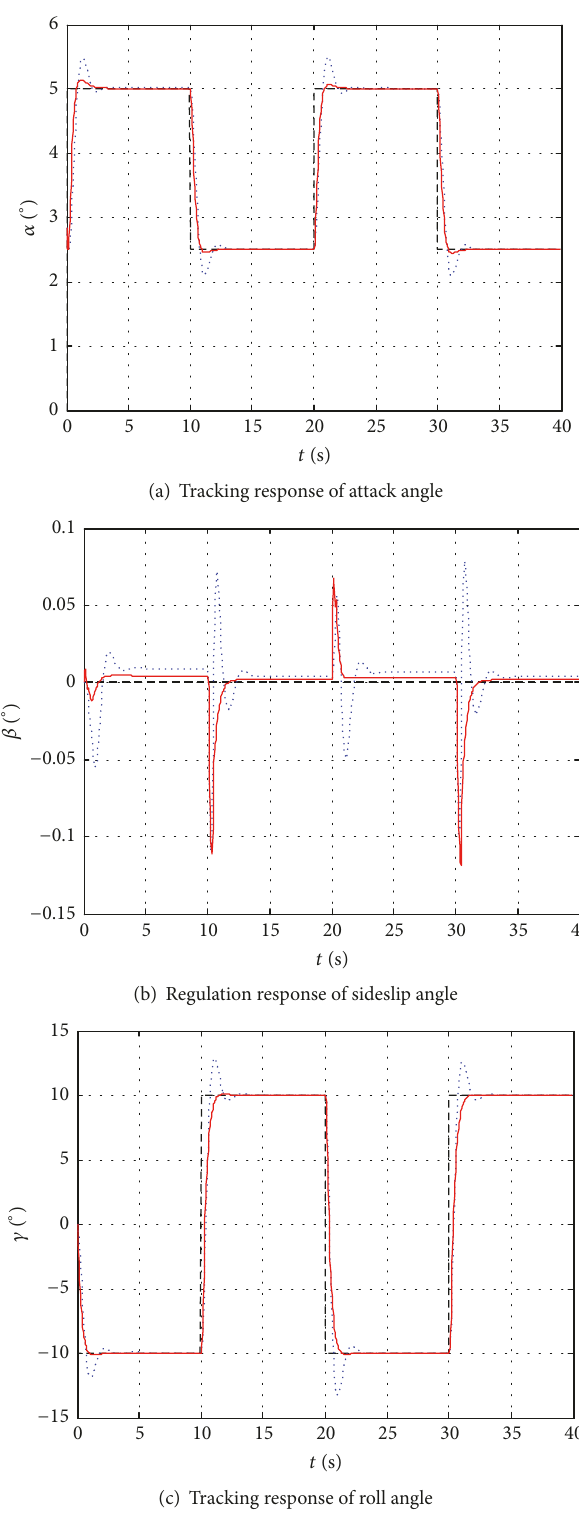
Figure 5: Tracking curves of three channel